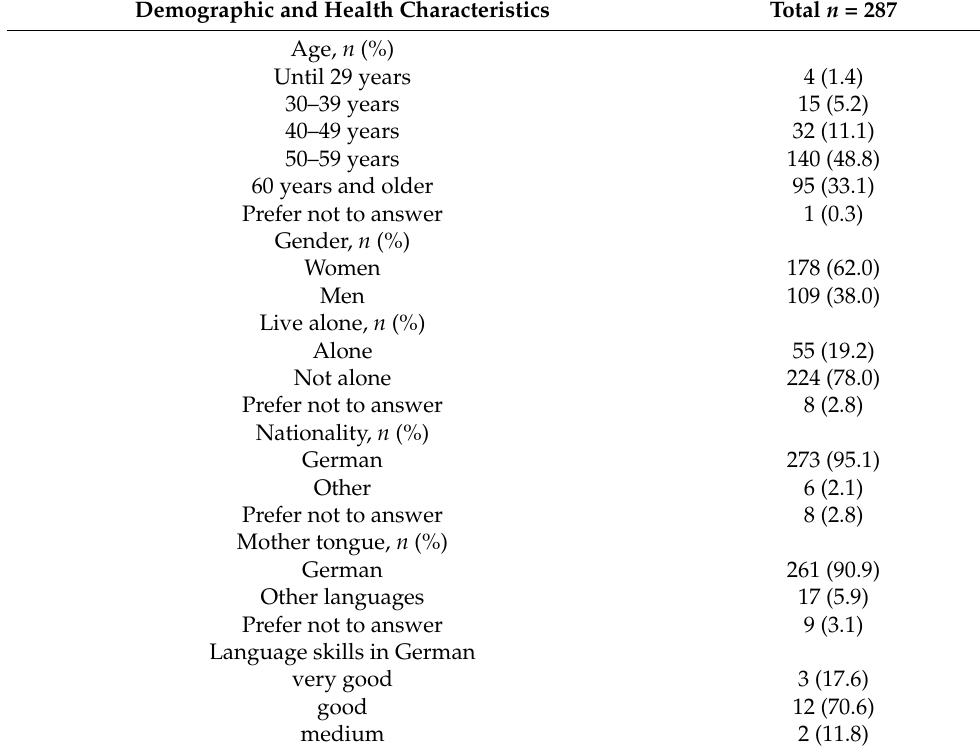
Table 1. Demographic characteristics of